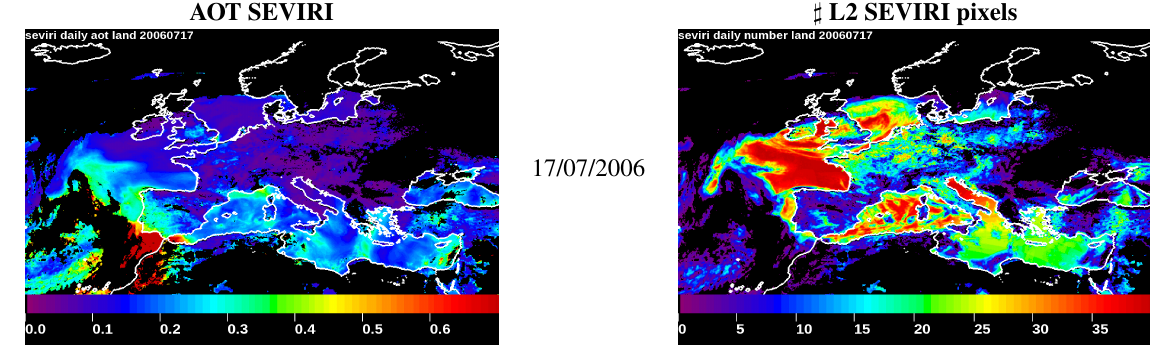
Fig. 13. Daily SEVIRI maps above Europe on the 17 July 2006: on the left the AOT at 0.6 µ m and on the right the quantity of L2 pixels to process the AOT daily average.